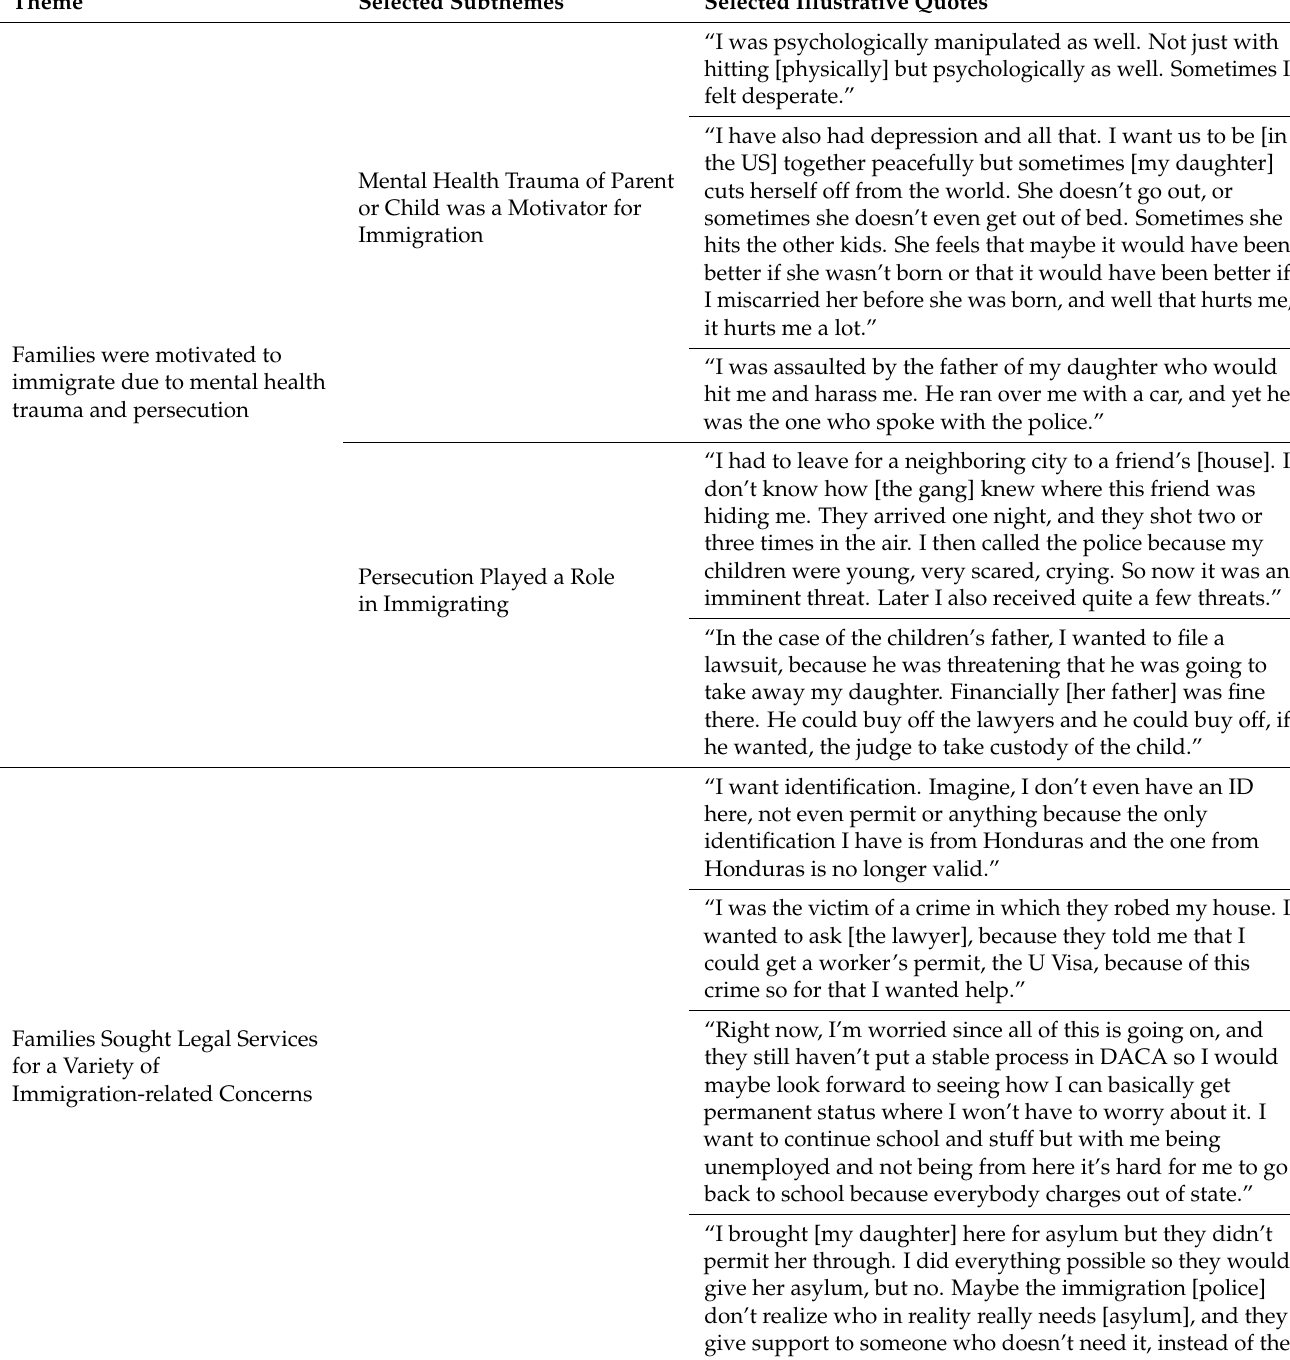
Table 4. Themes, Subthemes, and Representative